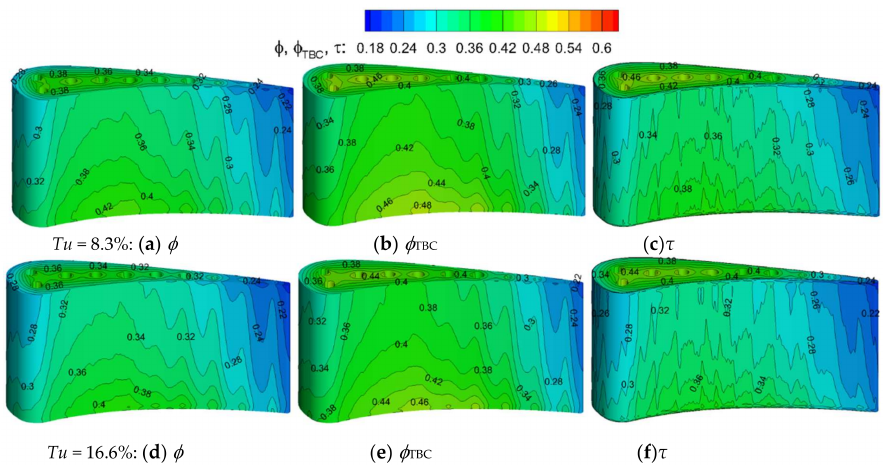
Figure 11. ϕ , ϕ TBC , and τ on the pressure side (PS) at Tu = 8.3% and 16.6%.